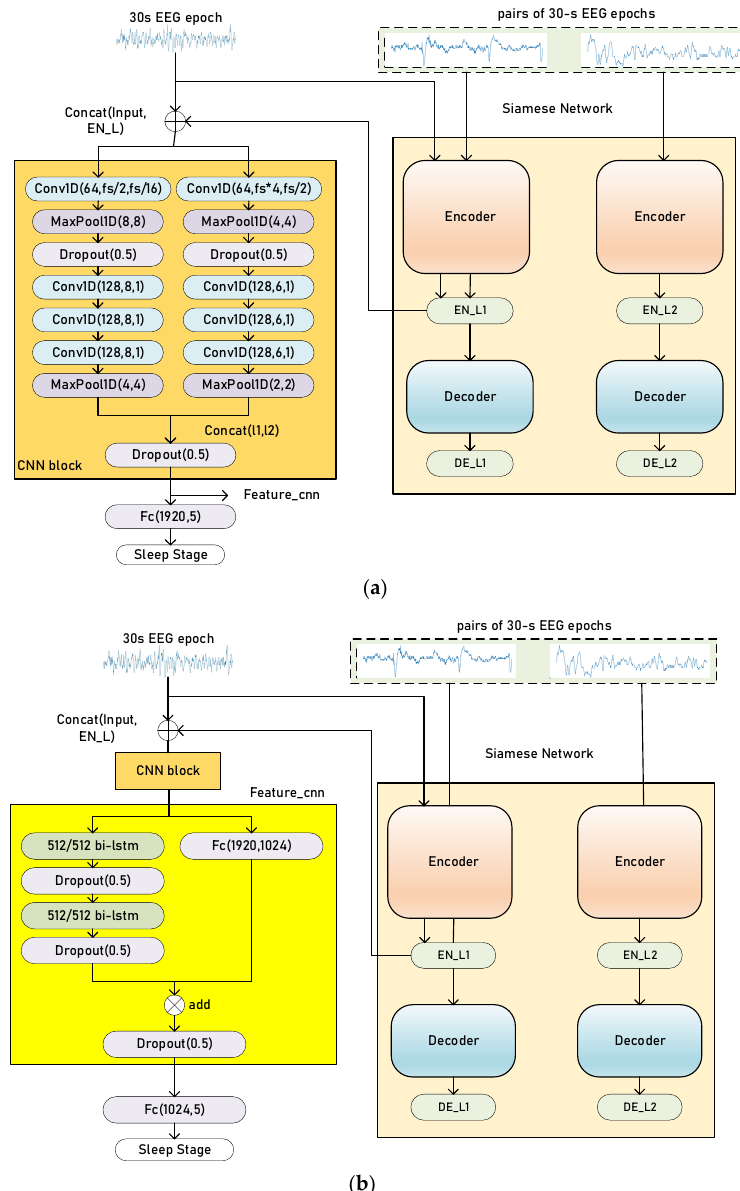
Figure 3. Illustration of the training process of our proposed method, pretraining ( a ) and finetuning ( b ). The Siamese network architecture is Siamese AEs. The CNN block, in orange ( a ), extracts time-invariant features, and the sequence residual block, in yellow ( b ), extracts temporal information from a sequence of EEG epochs. Concat (l1, l2) refers to the concatenation of two vectors and fs is the sampling rate of EEG signals. The parameters in the Conv1d blocks and MaxPooling blocks are similar to Figure 2.